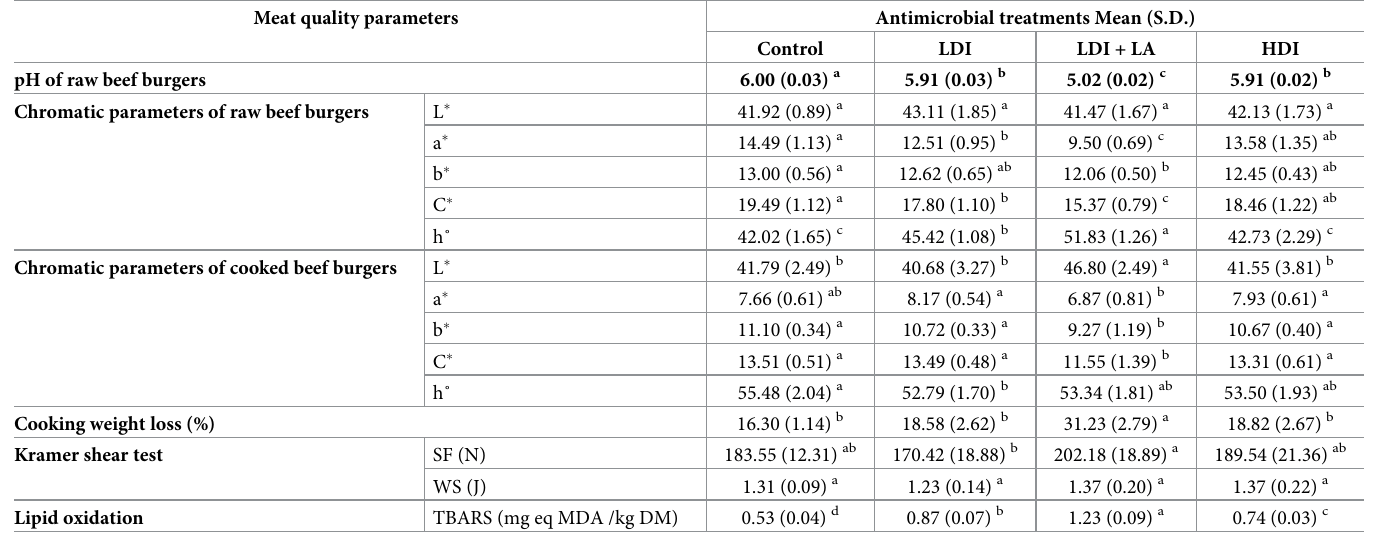
L � : lightness; a � : redness; b � : yellowness; C � : chromaticity; h˚: hue angle. a, b, c, d Interventions with no common letter differed significantly ( P < 0.05) using one-way ANOVA. LA, lactic acid (0.5%); LDI, low-dose irradiation (0.5 kGy); HDI, high-dose irradiation (2 kGy). SF, maximum shear force (N); WS, work of shearing (J); TBARS, thiobarbituric acid reactive substances.